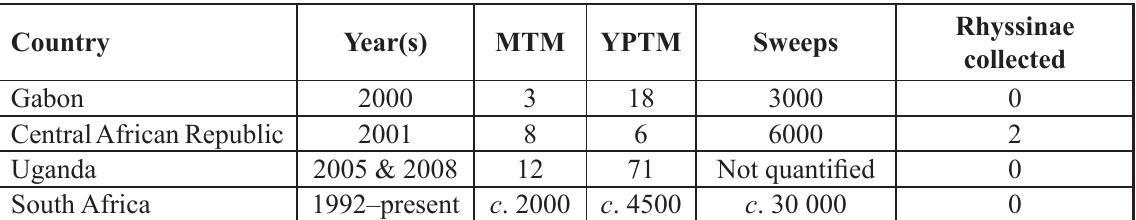
Table 1. Summary of the main collecting efforts by Simon van Noort of SAMC in Africa over the last 22 years (MTM: Malaise trap months; YPTM: yellow pan trap